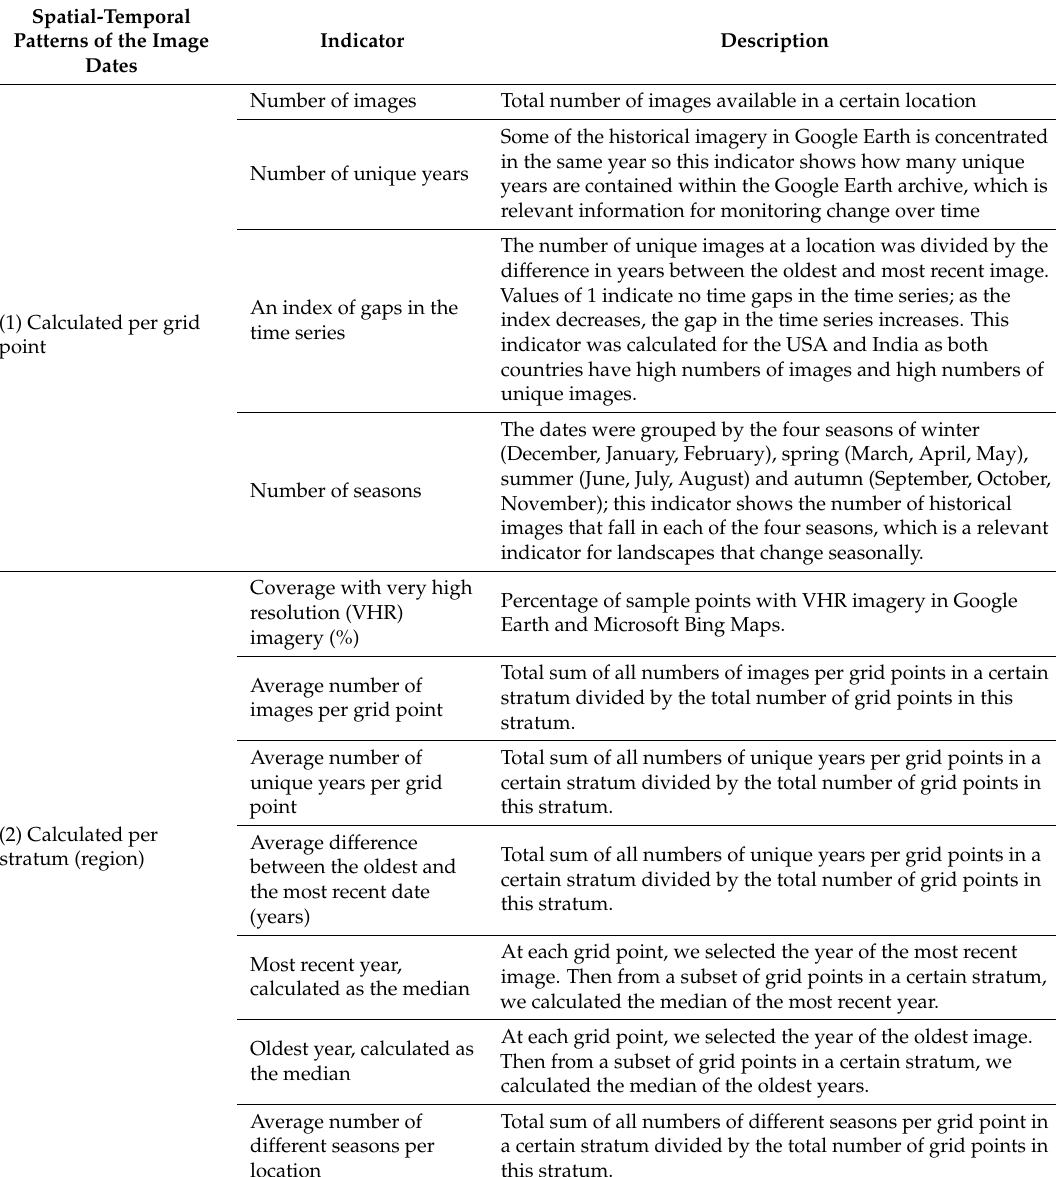
Table 1. Indicators calculated from the data extracted from Google Earth and Microsoft Bing Maps. Spatial-Temporal Patterns of the